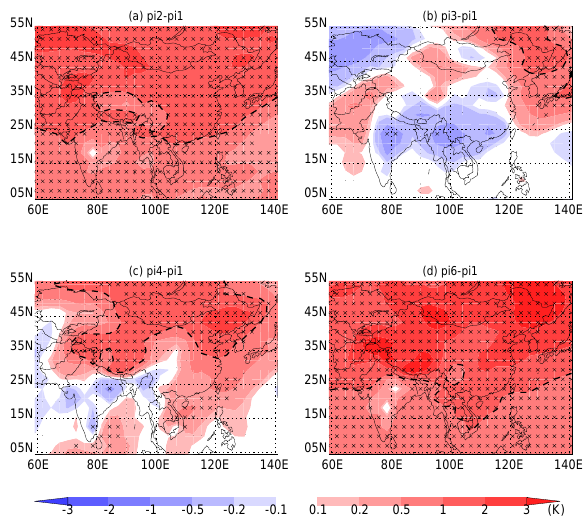
Fig. 8. Spatial distribution of surface air temperature change aver- aged for MAM for pi2-pi1 ( a , induced by CO 2 increase), pi3-pi1 ( b , induced by BC+OM in atmosphere), pi4-pi1 ( c , induced by BC in snow), and pi6-pi1 ( d , induced by CO 2 increase + BC+OM in atmosphere + BC-in-snow), respectively. Unit: K. Dash contour line is for 1 ◦ . Regions passing the 90% significance level are high- lighted by cross.